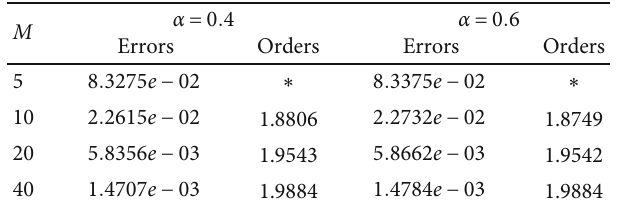
Table 2: The errors and convergence orders in spatial direction by using